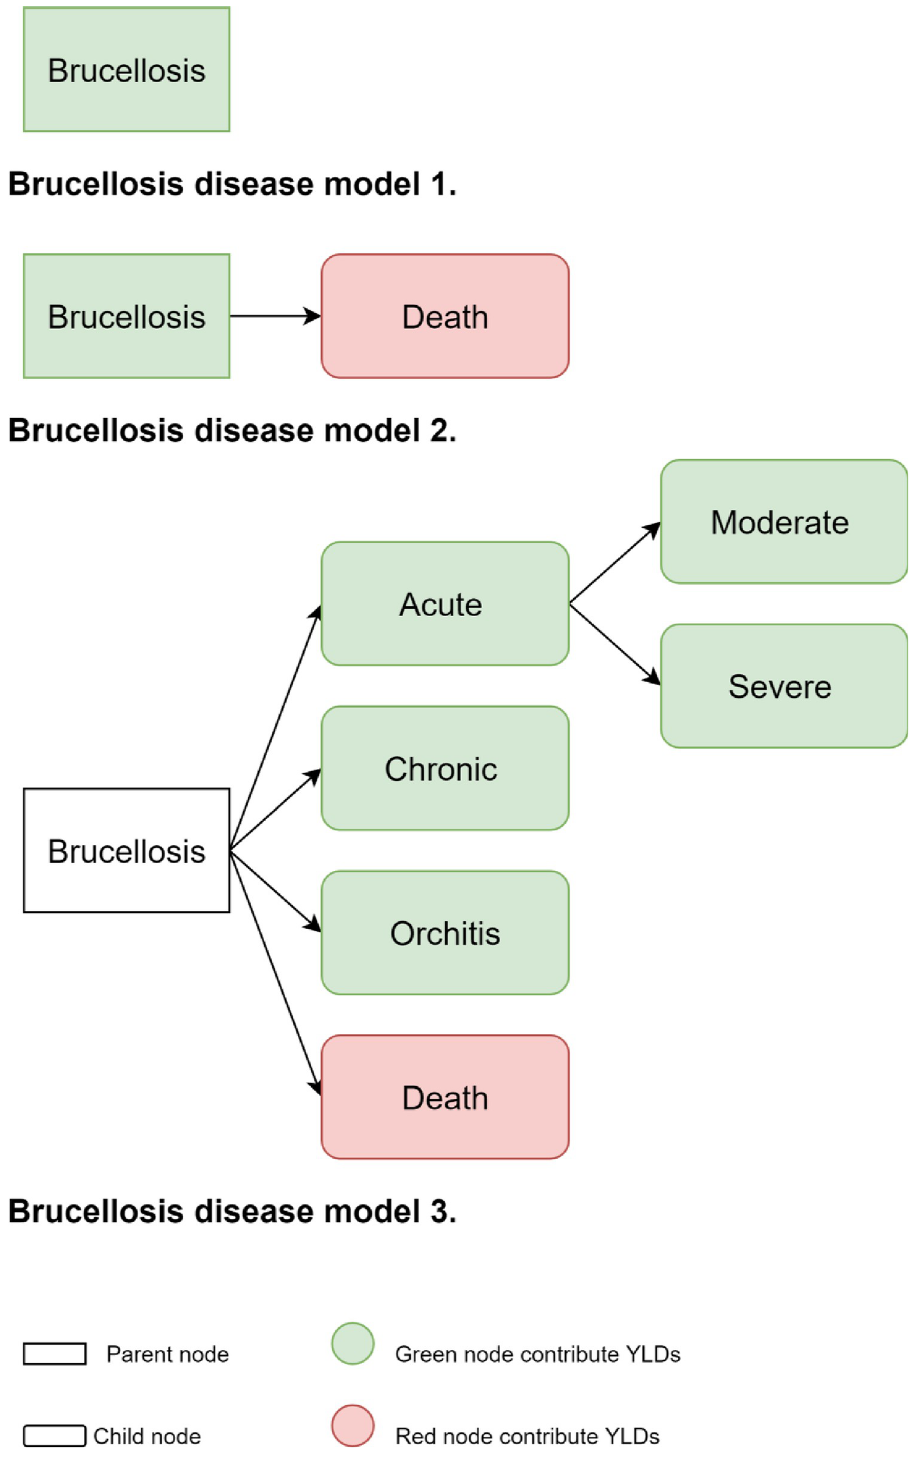
Fig 4. Disease models for brucellosis. Rectangles define the parent nodes, while rounded rectangles define the child nodes. White nodes do not contribute directly to the DALY estimate; green nodes contribute YLDs; and red nodes contribute YLLs. These models are not based on the biological or clinical pathway but they are computational disease models.